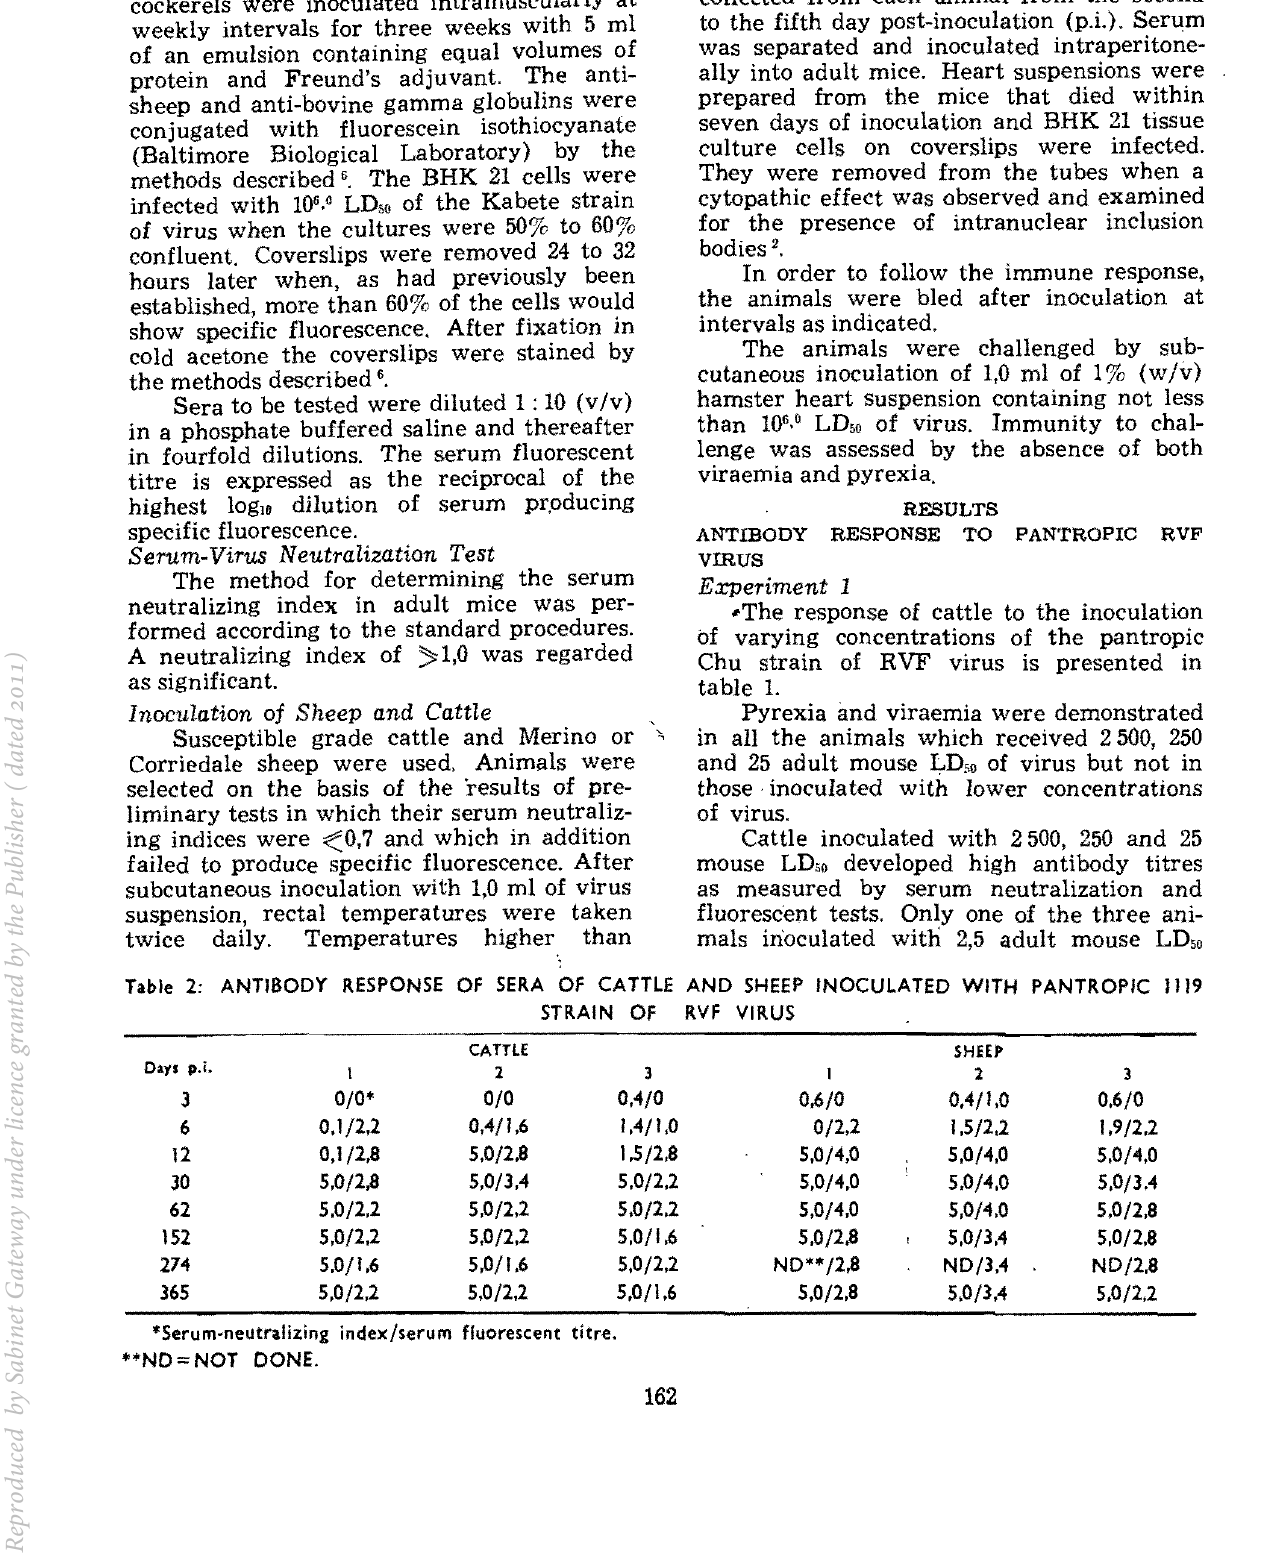
*Serum·neutrali:dng index/serum fluorescent